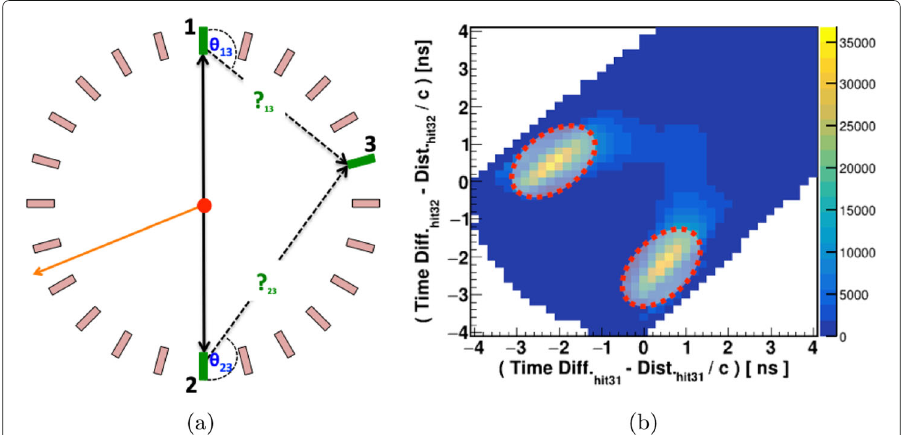
Fig. 7 a Pictorial representation of the event selection based on the algorithm used to tag the 511 keV photons. b The encircled dotted red lines show the selected scattering events of back-to-back photons based on the scatter test